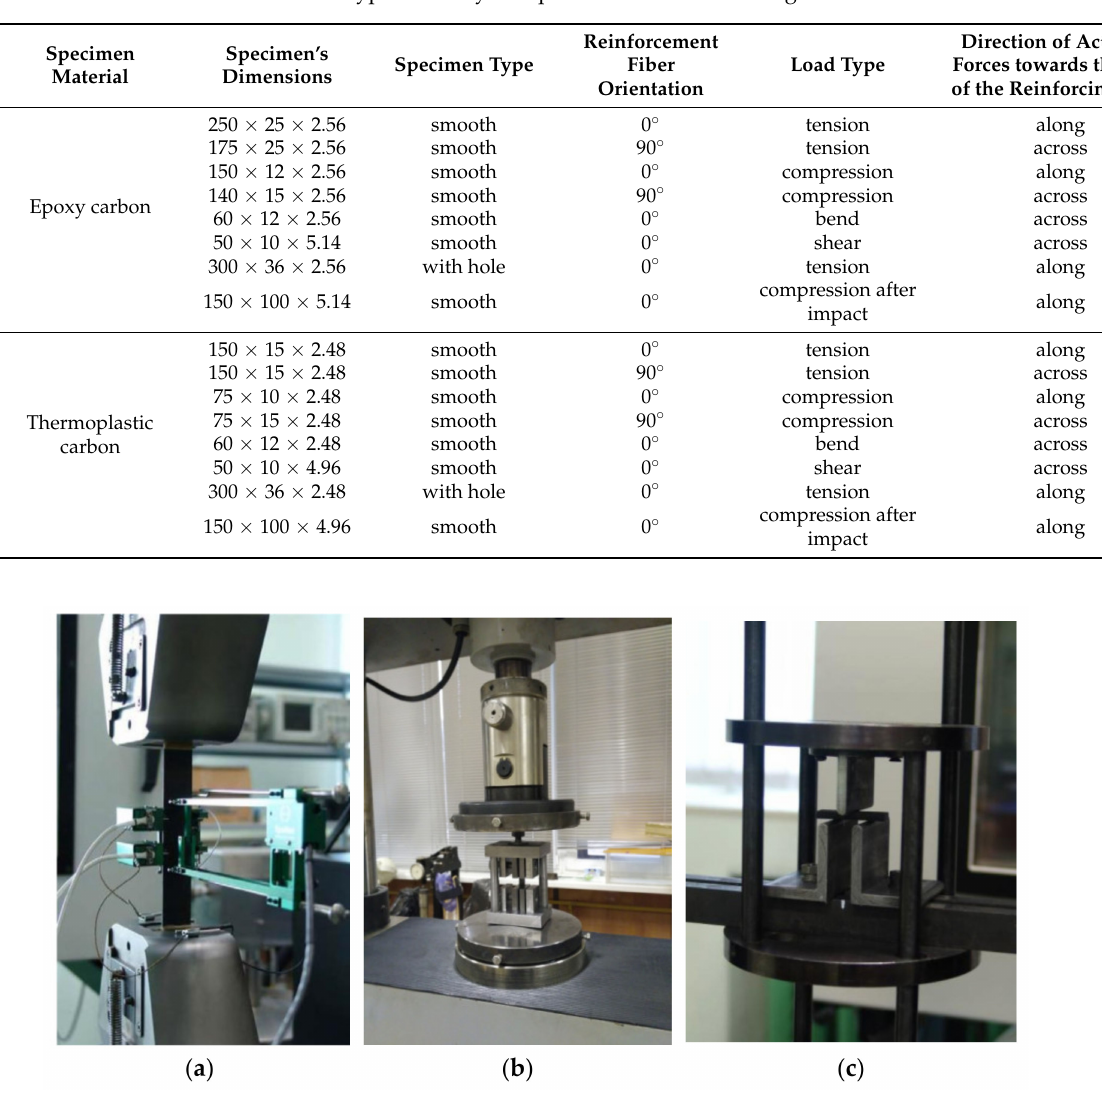
Figure 2. Testing machines for specifying the mechanical characteristics of specimens in tension ( a ), compression ( b ), and bending ( c